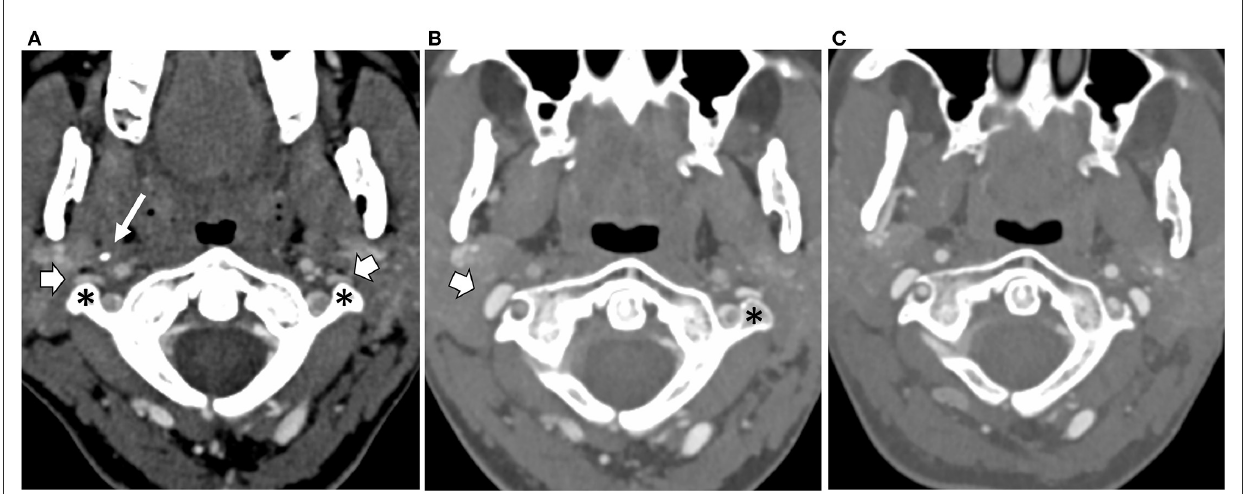
FIGURE3 Axial CT scans at the level of the C1 vertebra and odontoid peg following intravenous contrast injection, (A) at the baseline, (B) following resection of the right styloid and C1 transverse processes, and (C) following resection of the left C1 transverse process. The baseline scan (A) shows narrowing and flattening of both internal jugular veins (block arrows) as they pass in front of the transverse processes of C1 (asterisk) on either side. The styloid process of the skull (thin arrow) can be seen on the right side. (B) Following the right transverse process and styloid resections, the right internal jugular vein (block arrow) has expanded into the space created by the surgery. (C) Following left transverse process resection, the left internal jugular vein has now also expanded.